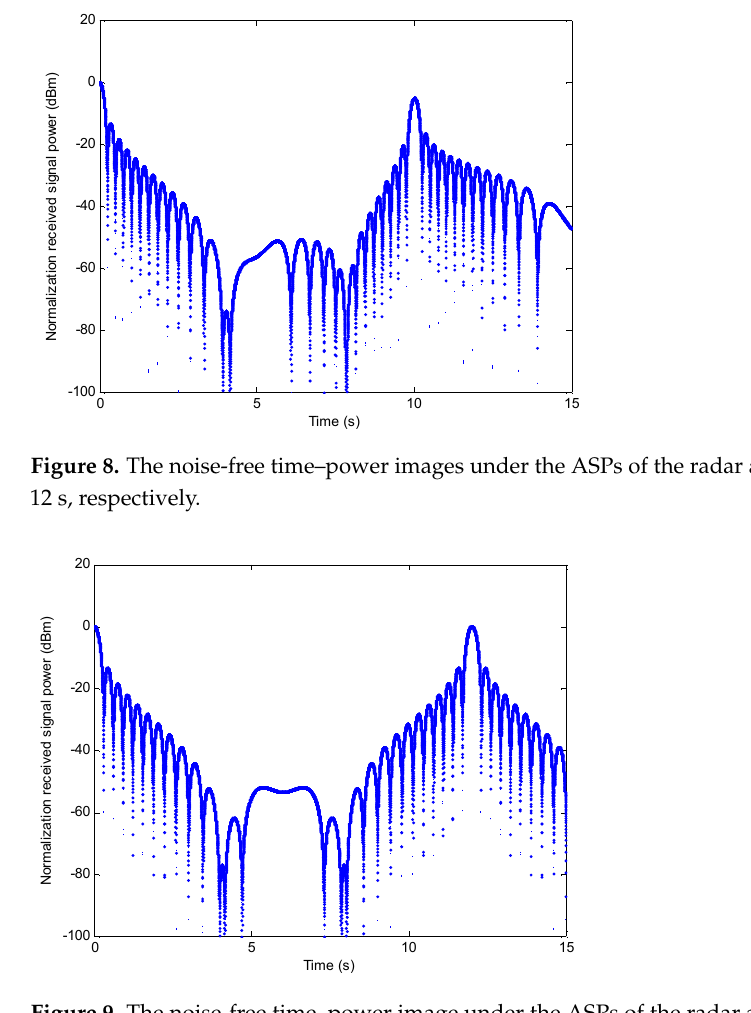
Figure 9. The noise-free time–power image under the ASPs of the radar and EW system of 12 s and 12 s, respectively.